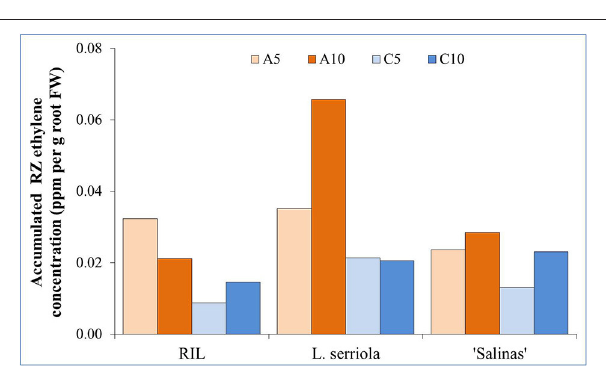
FIGURE 5 | Accumulated RZ ethylene concentration per unit root FW, measured at 1300 h on a sunny day, 28 days after transplanting into an aeroponic system. L. serriola , “Salinas” and the RIL were planted in four different experimental conditions of A5, A10, C5, and C10. Each bar graph is the mean of 3 consecutive measurements for each growing condition ( n =